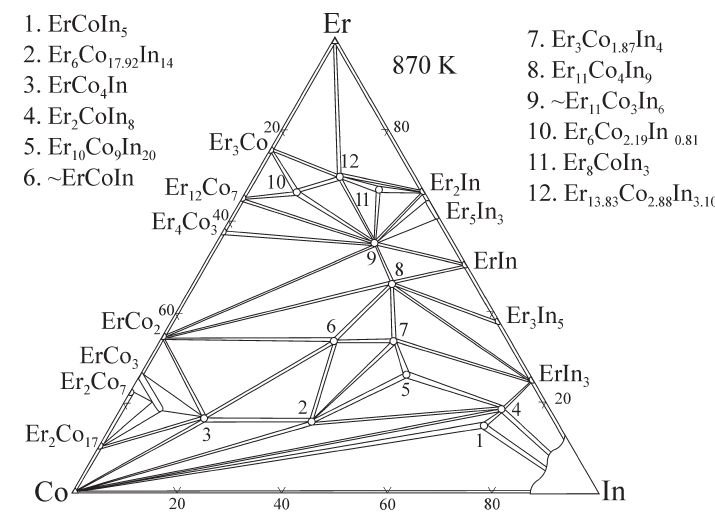
Figure1. The isothermal section of the Er-Co-In system at T = 870 К .